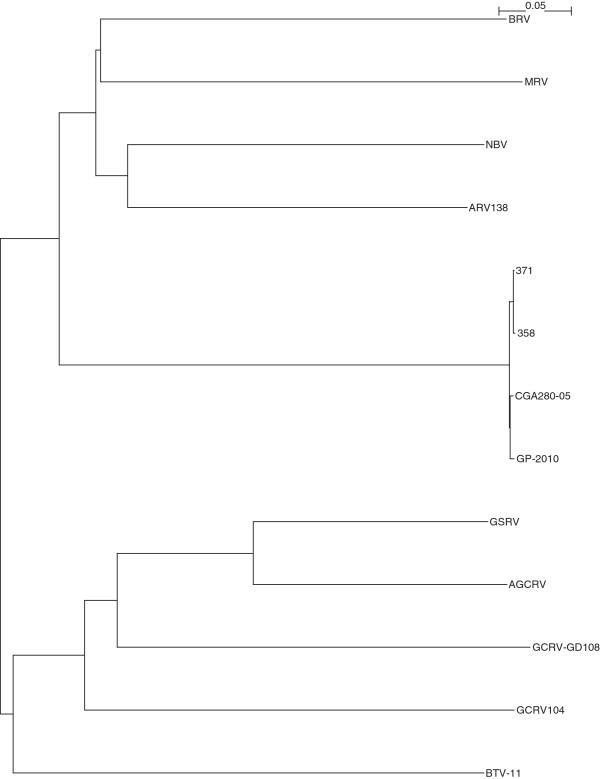
Phylogeny of homologous segment M1 shared by piscine reovirus (PRV) and selected members of familyReoviridae.